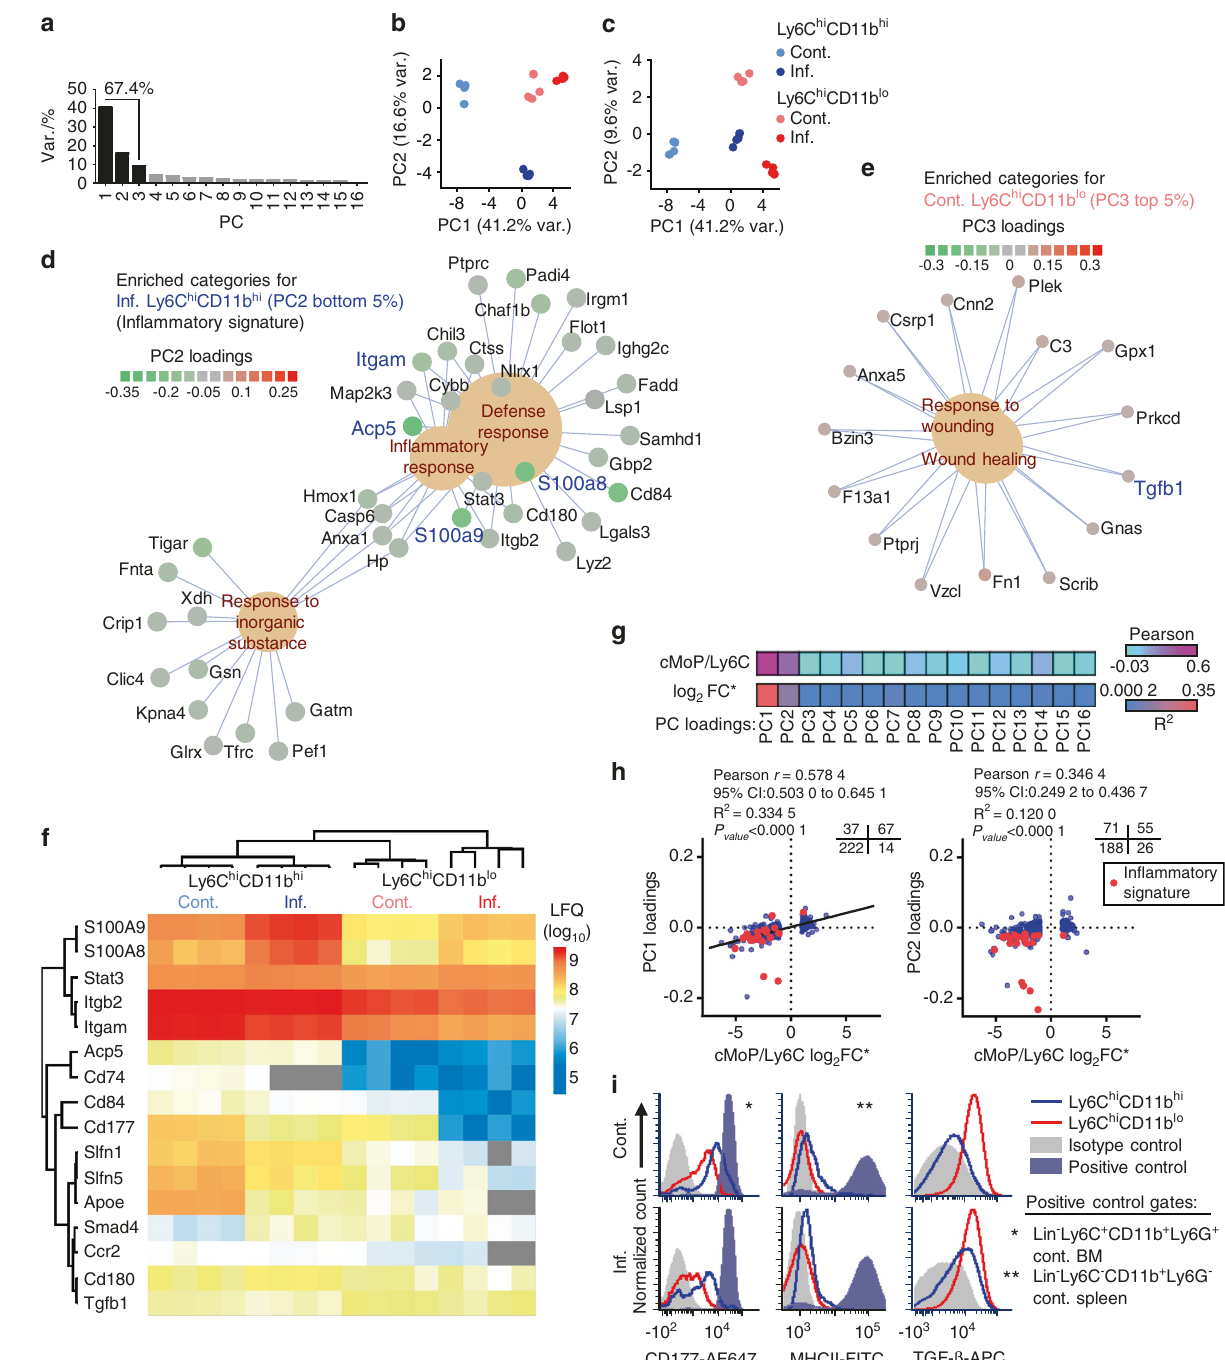
Fig. 4 Immune-in fl ammatory proteomic pro fi le is observed in Ly6ChiCD11bhi cells but not Ly6ChiCD11blo cells. a A scree plot for the PCA is presented. b Projection plot for PC1 and PC2. c Projection plot for PC1 and PC3. d Gene concept network of proteins in enriched categories in the bottom 5% of PC2 loading scores (characteristic for in fl amed Ly6C hi CD11b hi cells). e Proteins in enriched categories in the top 5% of PC3 loading scores (characteristic for control Ly6C hi CD11b lo cells). The Benjamini – Hochberg FDR was set to 0.05 for all GO analyses (see detailed results in Fig. S4). f Heatmap of selected key proteins residing in either the PC1 or PC2 bottom 5% or PC3 top 5% of loading scores. g Pearson coef fi cient and R 2 heatmap of PC loadings vs . the cMoP/Ly6C signature (log 2 FC) reported by Hettinger et al., 2013 18 . h Scatterplot of PC1 and PC2 loadings vs . the cMoP/Ly6C signature (log 2 FC) (340 proteins detected in both datasets). Quadrant counts indicated (top right). i Cell surface expression of the markers CD177, MHCII and TGF- β in control and in fl amed Ly6C hi CD11b hi and Ly6C hi CD11b lo cells. Positive controls are indicated by